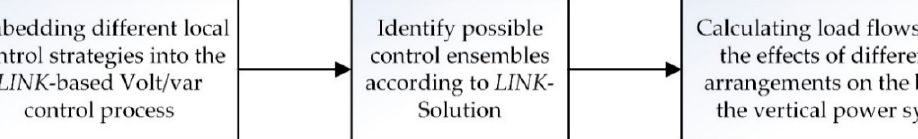
Figure 1. Methodology used to investigate the effects of individual control strategies in the LINK -based Volt/var control process.